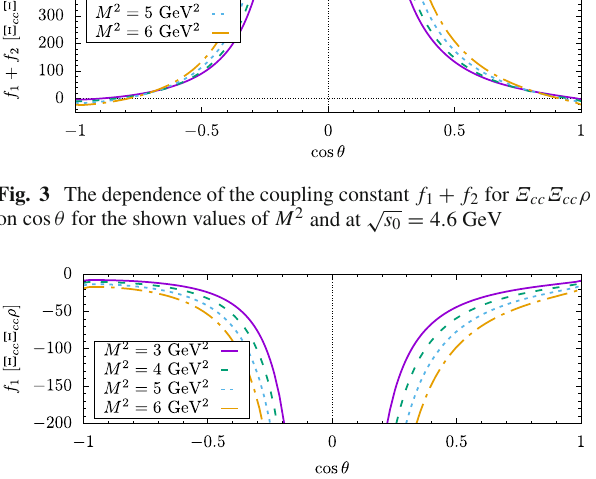
Table 2 The working region of the parameters M 2 and s 0 for the chan- nels considered in our work